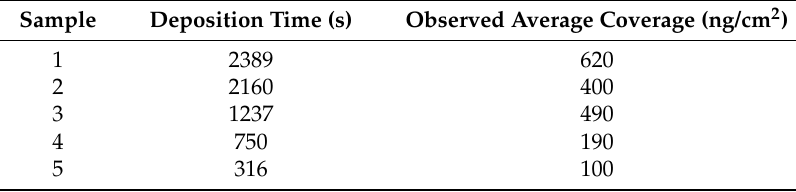
Table 1. Sample fabrication